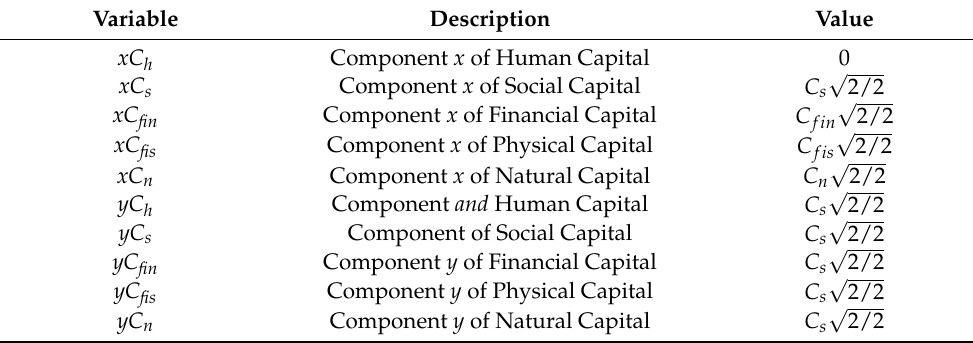
Table 2. Value of each component for the five capitals